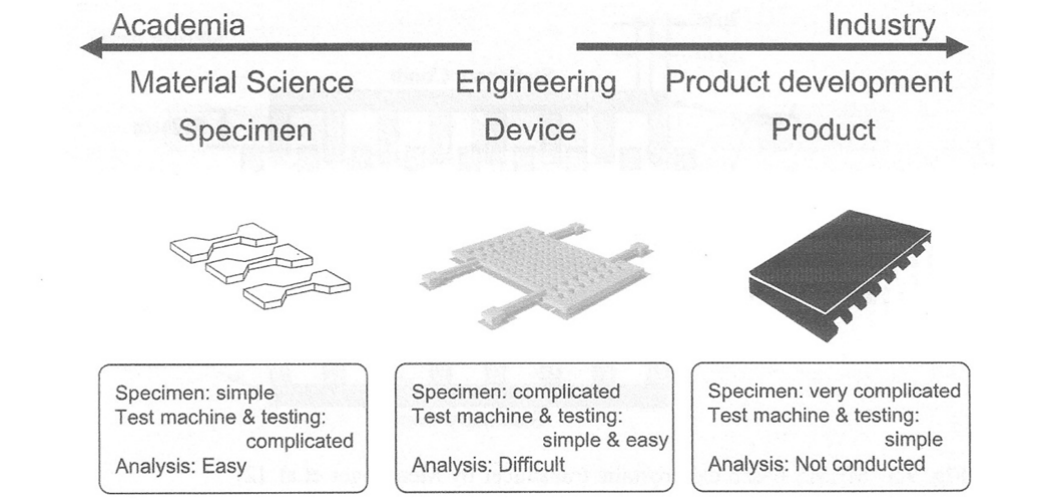
Figure 6 Three levels of reliability evaluation